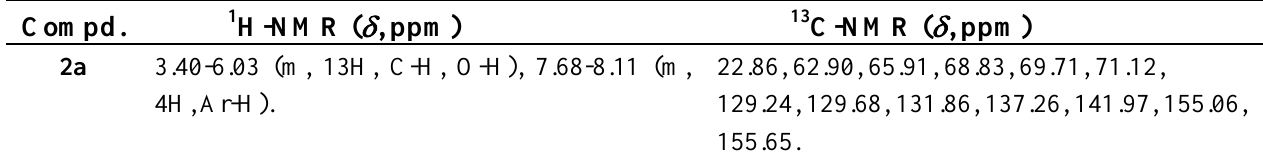
Table 4. NMR data of compounds 2a ~ 2h , 3a ~ 3h